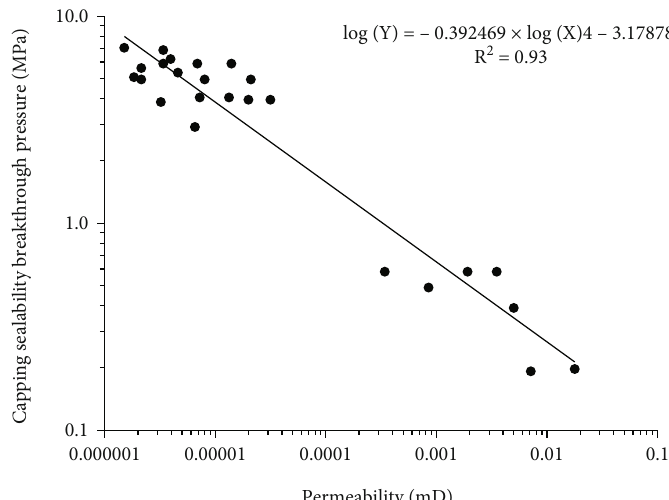
Figure 16: Double logarithmic relationship between capping sealability breakthrough pressure and permeability in the literature.